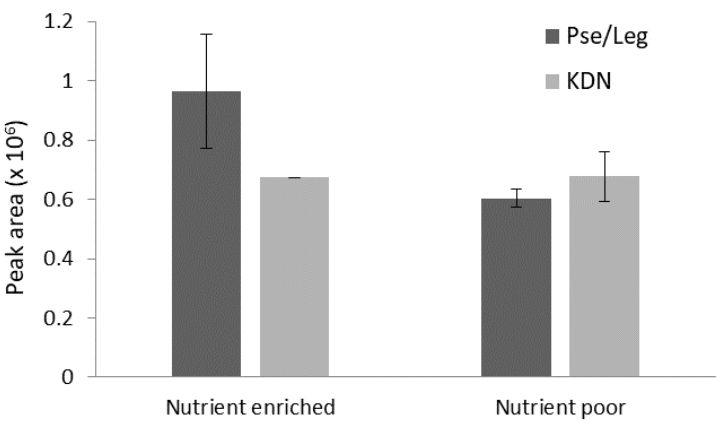
Figure 3. Observed mass spectrometric peak areas of sialic acids in nutrient enriched and nutrient poor biofilm extracellular polymeric substances (EPS). The error bars represent the minimum and maximum values. Abundances of both sialic acids were not significantly different between the samples ( p -values > 0.05).